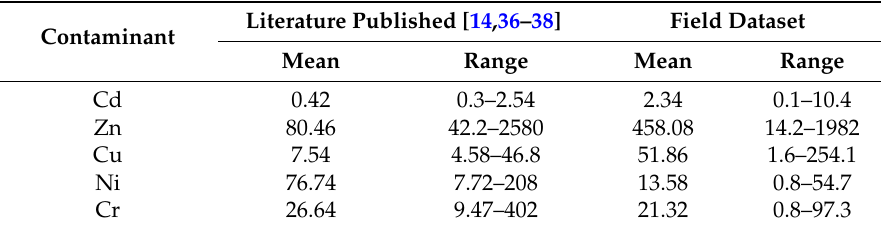
Table 4. Comparison of published and field wetland contaminant